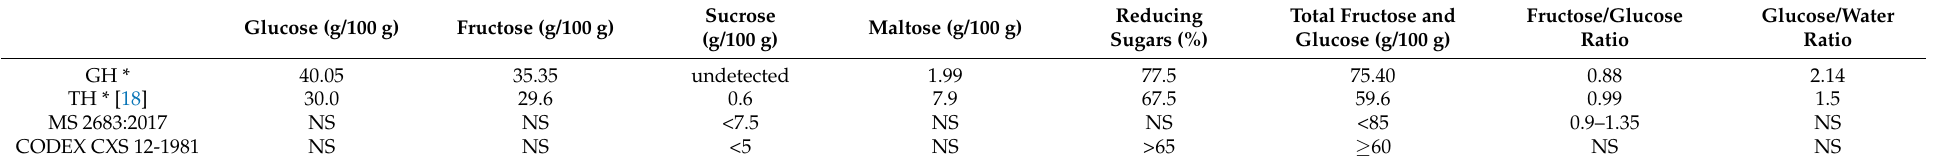
Figure 1. HPIC chromatograms of ( a ) the sugar standard versus ( b ) the sugar profile of Gelam honey. The retention times of the identified sugars are: glucose, 8.392 min; fructose, 10.808 min; maltose, 28.975 min. Table 2. Comparison of sugar contents in Gelam honey (GH), Tualang honey (TH) and MS 2683:2017 with CODEX CXS 12-1981